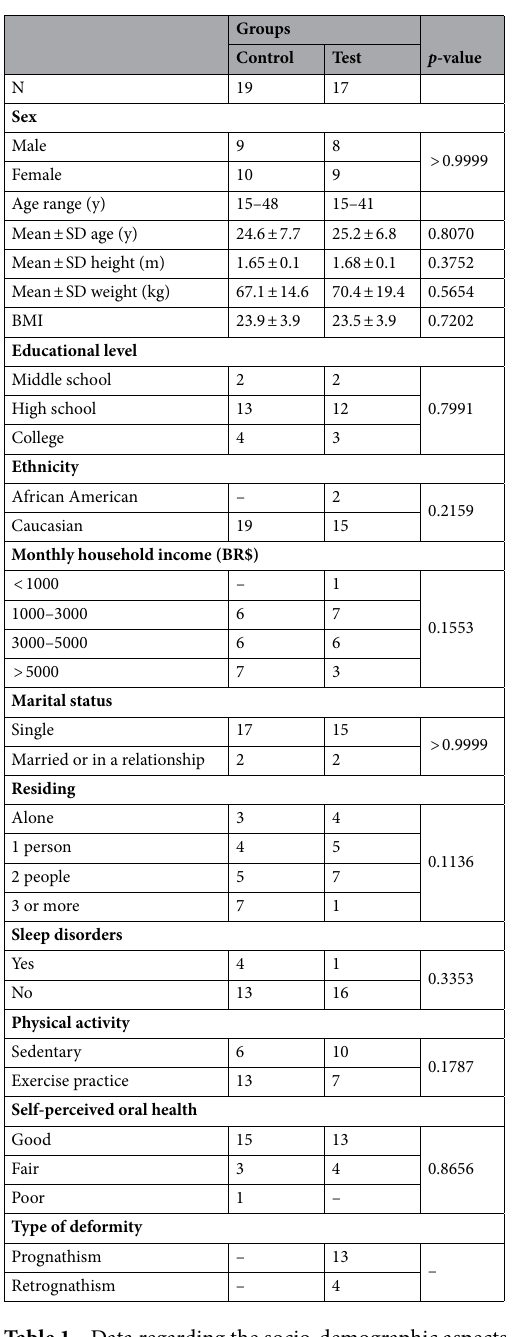
Correlation analysis. To correlate the psychosocial determinants and the biochemical results, Pearson’s correlation analysis was carried out. A positive correlation was observed between the salivary glutamate con- tents and the function domain scores of the OQLQ instrument ( r = 0.61; p = 0.0095), according to the evalua- tion of the test group. The elevated salivary levels of IL-1β did not show any correlation with the OQLQ scores ( r = − 0.24; p = 0.35), or with the social aspects ( r = − 0.28; p = 0.27), the dentofacial esthetics ( r = − 29; p = 0.26), and the function domains ( r = 0.04; p = 0.86). No significant correlation was observed between the glutamate levels and the OQLQ scores ( r = 0.31; p = 0.22), or the social aspects ( r = 0.09; p = 0.74) and the dentofacial esthet- ics ( r = 0.27; p = 0.29) domains. An overall analysis did not show a significant correlation between age, and the IL-1β ( r = 0.056; p = 0.74) or the glutamate ( r = − 0.09; p = 0.58) levels. Additionally, no significant correlation was found between the BMI, and IL-1β ( r = 0.1879; p = 0.27) or glutamate ( r = − 0.13; p = 0.44) contents.